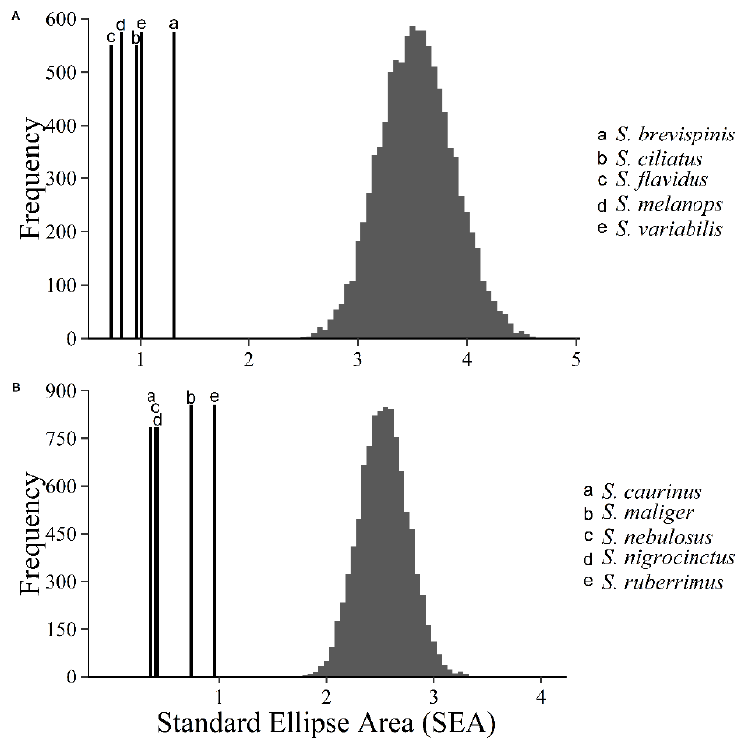
Figure 4. Comparison of trophic niche size for pelagic and demersal rockfish. Each panel shows the SEA distributions based on the resampling of the isotopic values for pelagic ( A ) or demersal rockfish ( B ). Actual SEA of each rockfish species is represented by the bolded vertical lines.